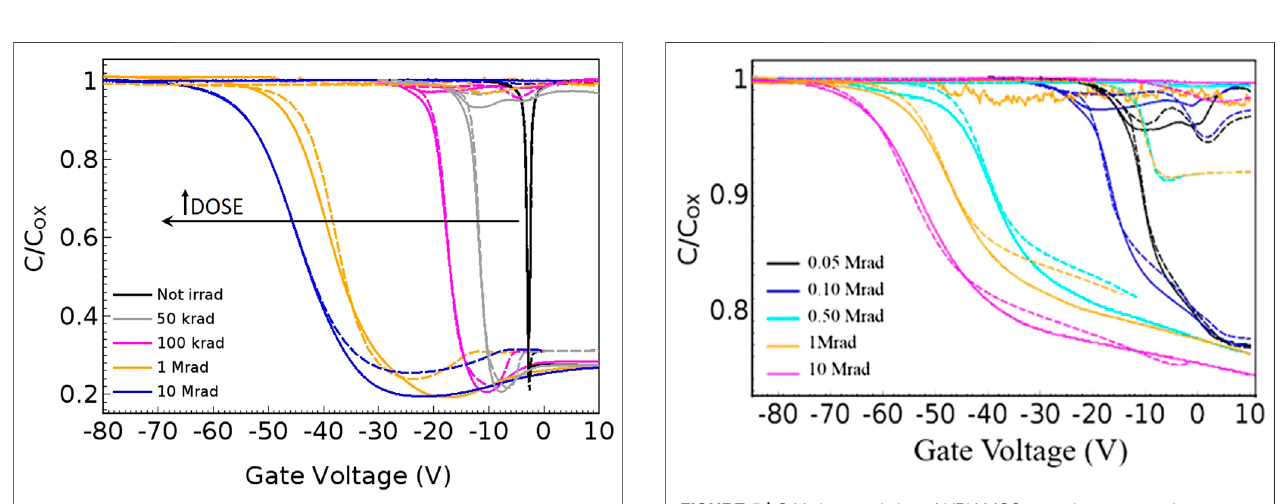
given irradiation dose. In all pictures reported below, the solid lines are used to symbolize the measurements while the dashed lines represent the simulation fi ndings.